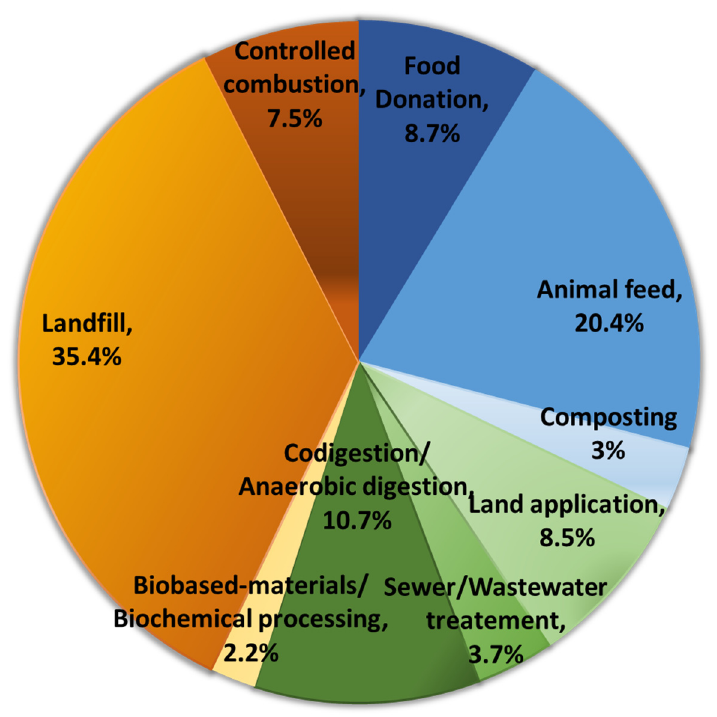
Figure 1. Percentage distribution of excess food and food waste management in U.S.A. generated in the industrial, residential, commercial and institutional sectors, 2016 [31]. Landfill, incineration, composting, anaerobic digestion, pyrolysis, animal feed, biochemical processing, are some of the methods that have been employed to recover the energy in food waste [32].